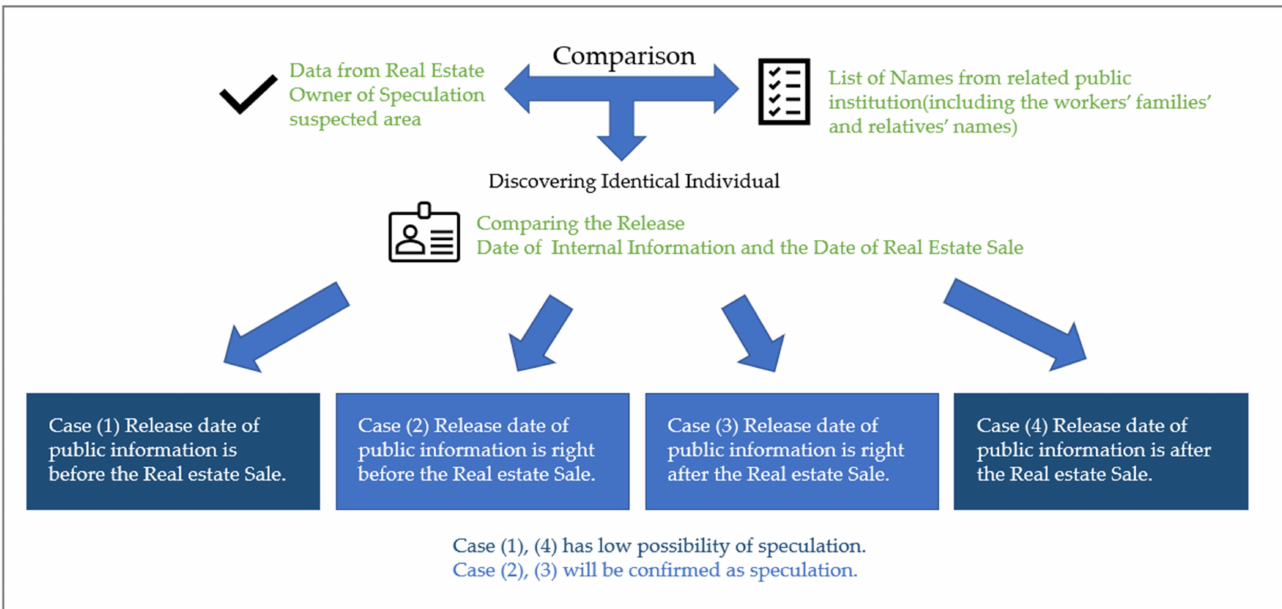
Figure 7. The Comparison